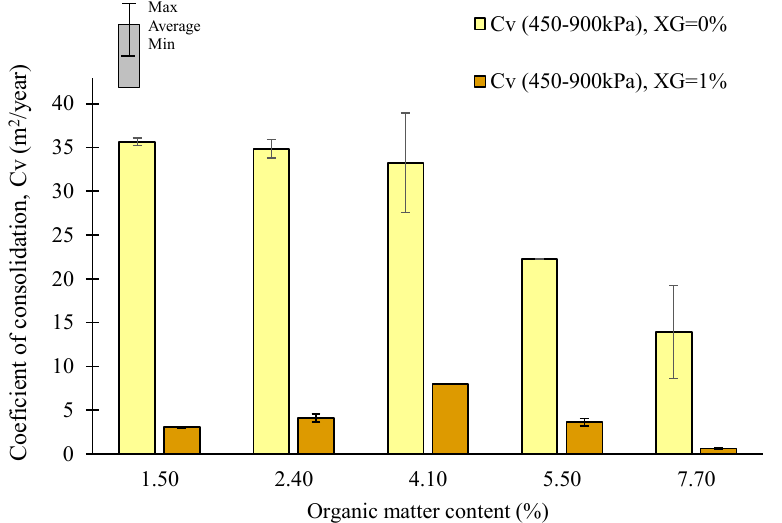
Figure 9. Oedometer tests. Effect of organic matter content on the coefficient of consolidation (Cv) during the increments in compression stress (405 to 900 kPa).